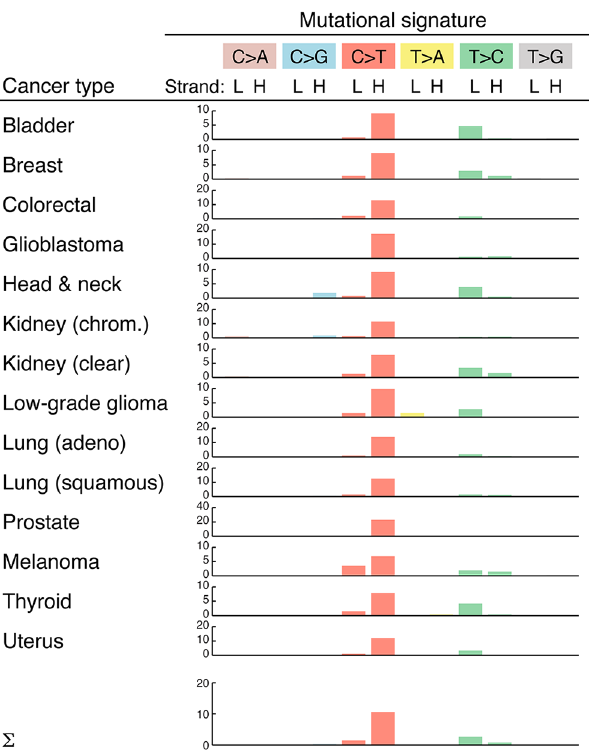
Fig 3. Overview of mtDNA mutational signatures. Substitution patterns (mutational signatures) are shown for each cancer type, which each substitution class labeled by the pyrimidine of the Watson-Crick pair [31] but with sense and antisense patterns shown separately to reveal strand biases. Bars indicate enrichment relative to the expected frequency (observed/expected ratio) for all possible substitutions, taking into account the nucleotide composition of mtDNA and assuming equal probability for all three substitutions. L, light strand; H, heavy